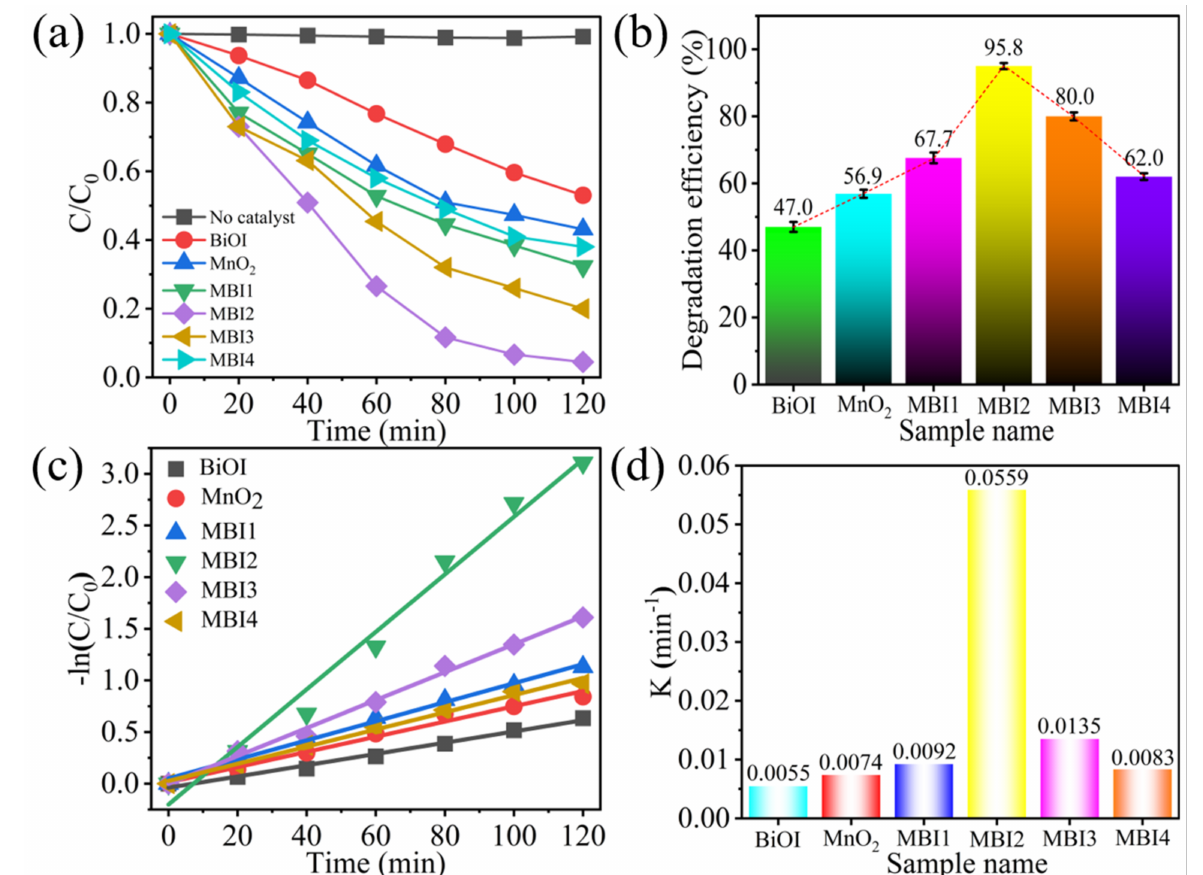
Figure 10. ( a ) PEC activities of different samples for the degradation of 30 mg/L TC under visible light irradiation ( λ > 420 nm); ( b ) histogram of the degradation efficiency of different samples to TC; ( c ) kinetic rate constants of TC over different samples; and ( d ) histogram of degradation rate constants of different samples to TC (30 mg/L, pH = 6.58).